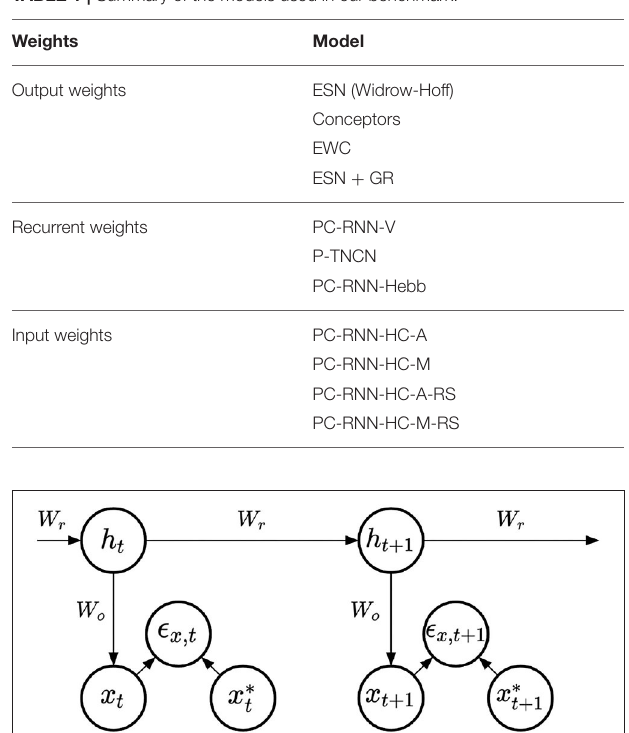
TABLE 1 | Summary of the models used in our benchmark.